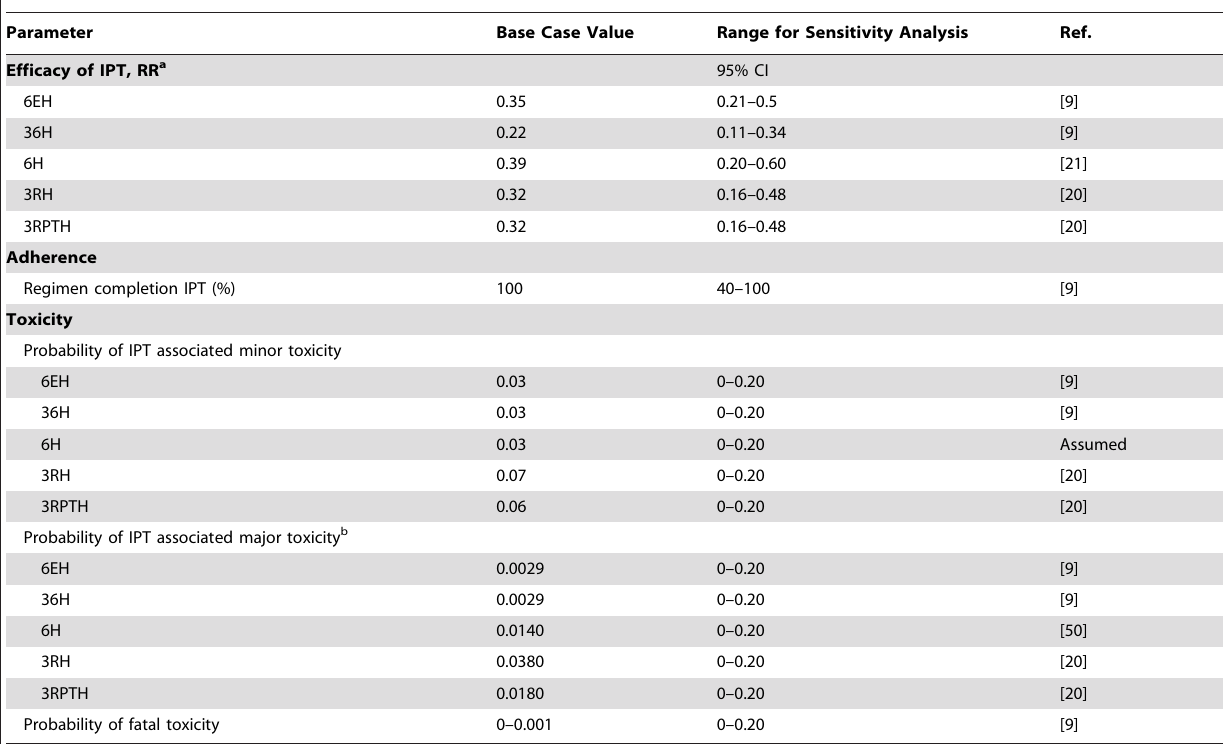
Table 2. Efficacy and toxicity of